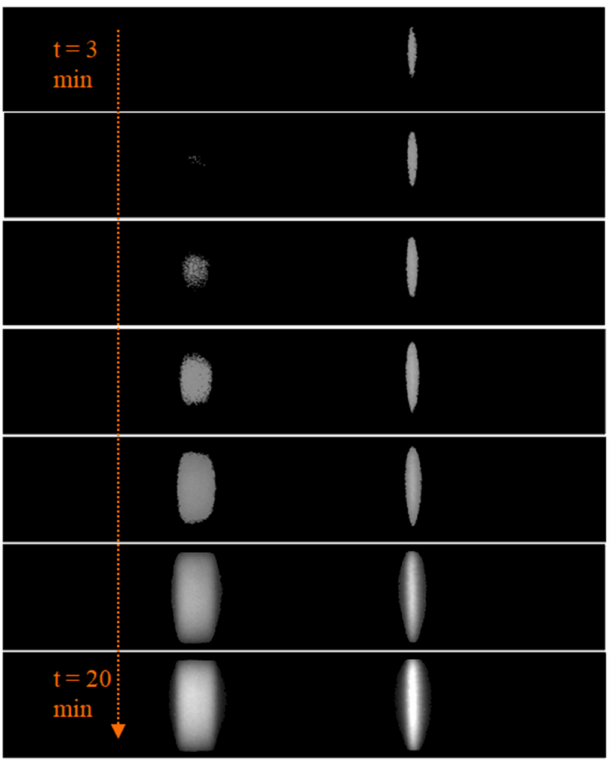
Figure 10. The intermediate segmented test and control regions obtained for tracking the reaction progress of sample under test once the sample flow is complete, from time t = 3 min to t = 20 min.